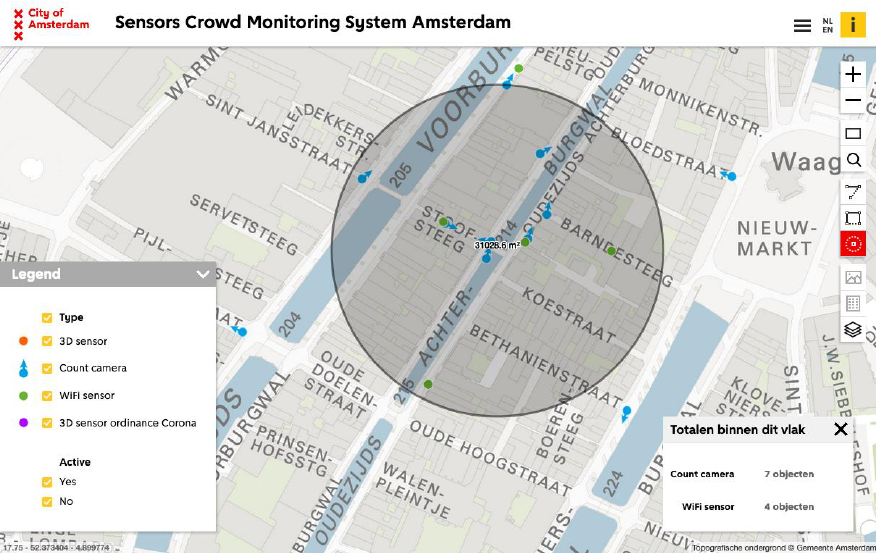
Figure 3. All Crowd Monitoring Sensors within 100m of the Bridge.